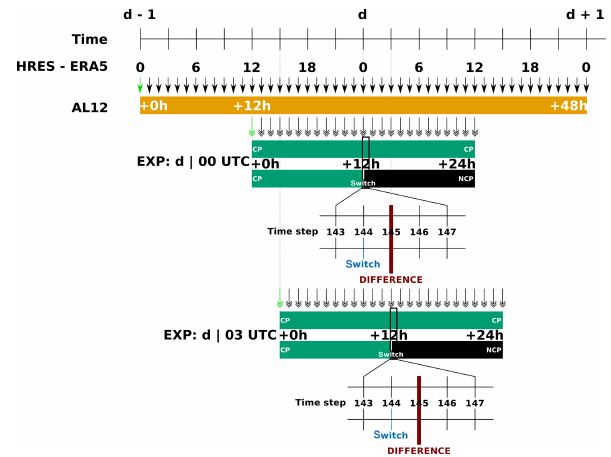
Figure 3. Organization of the different runs used to evaluate the flux differences. Both runs start with deep-convection parameterization (CP), while one of the forecasts switches off the parameterization after 12h (NCP). Here an example is shown for evaluation of the transport flux error at 00:00 and 03:00UTC. In practice such an evaluation is done every 3h between 00:00UTC on 2 April 2009 and 21:00UTC on 10 April 2009. A green single arrows indicates initial conditions were provided by the ERA5 reanalysis, while a black single arrow means that the LAM was forced with ERA5 boundary conditions. Double arrows indicate initial and boundary conditions are provided from the 12km intermediate